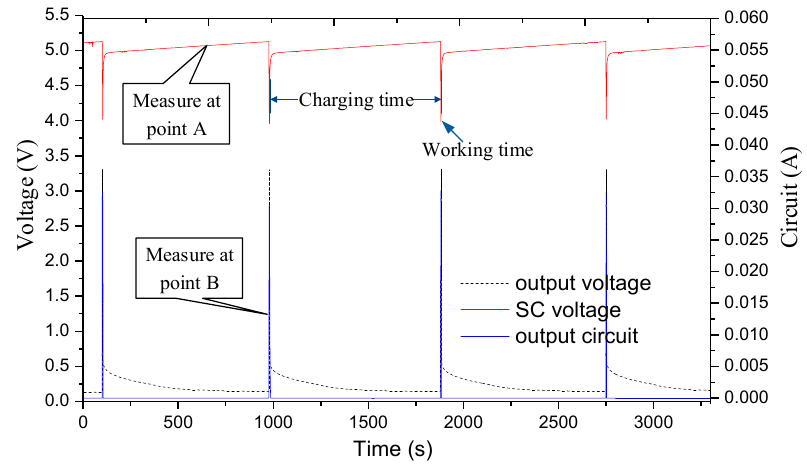
Figure 23. Monitoring energy harvesting and power supplying at points A and B in Figure 2.